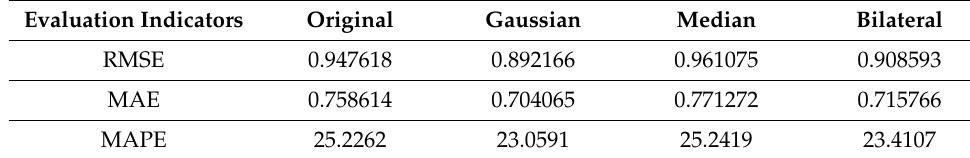
Table 6. Average loss value of evaluation